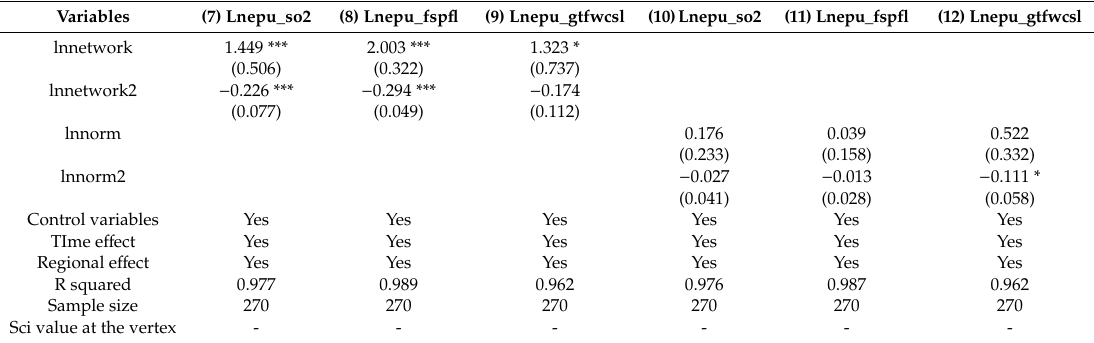
Table 5. Regression results of environmental pollution